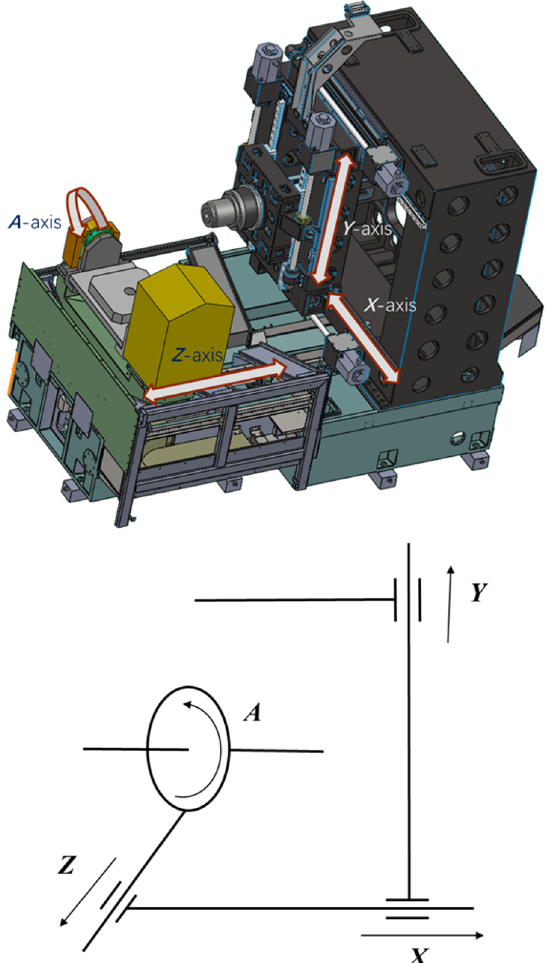
Figure 5 The structure and topological structure of a horizontal machining